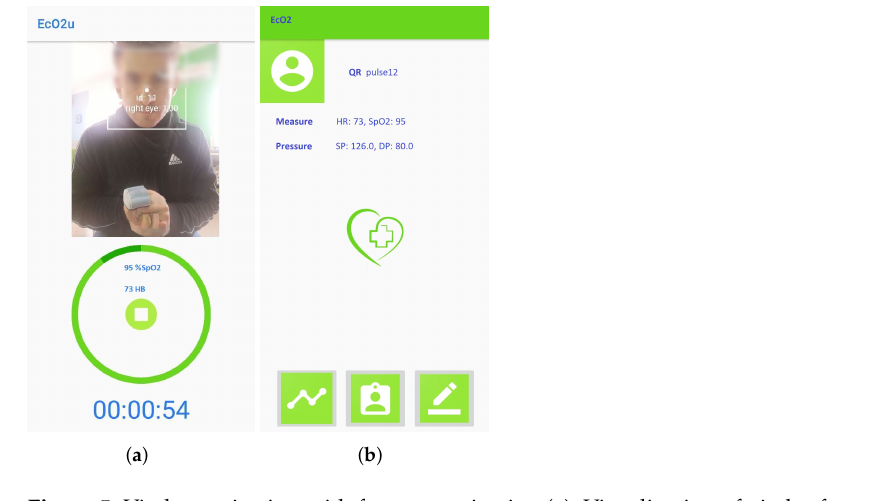
Figure 5. Vitals monitoring with face recognization ( a ); Visualization of vitals after completing the measurement ( b